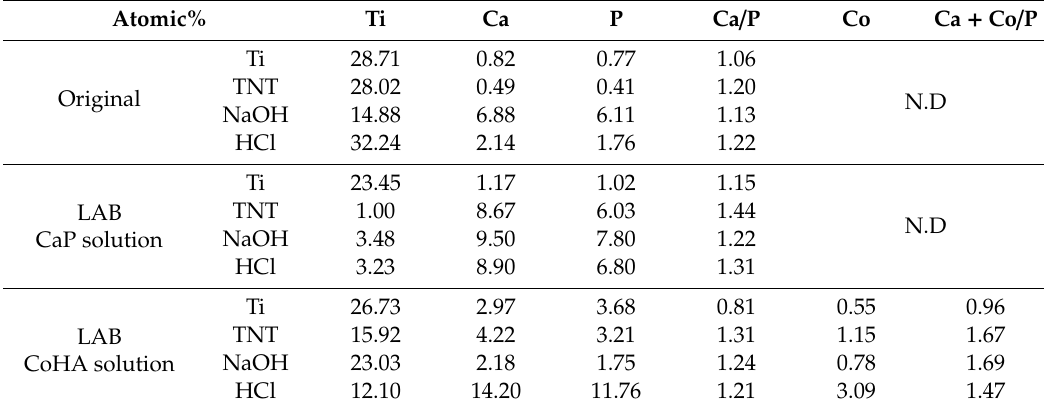
Table 3. Surface element analysis of the LAB-treated samples after soaking in SBF for seven days by EDX.